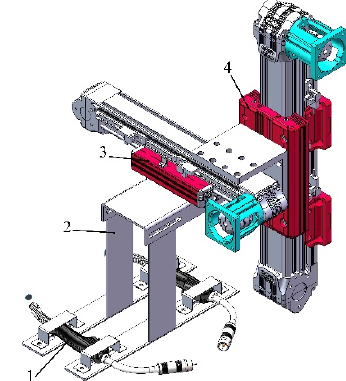
Figure 15. Welding actuator structure diagram. 1. Welding torch; 2. welding torch bracket; 3. X axis linear slider; 4. Z axis linear slider.